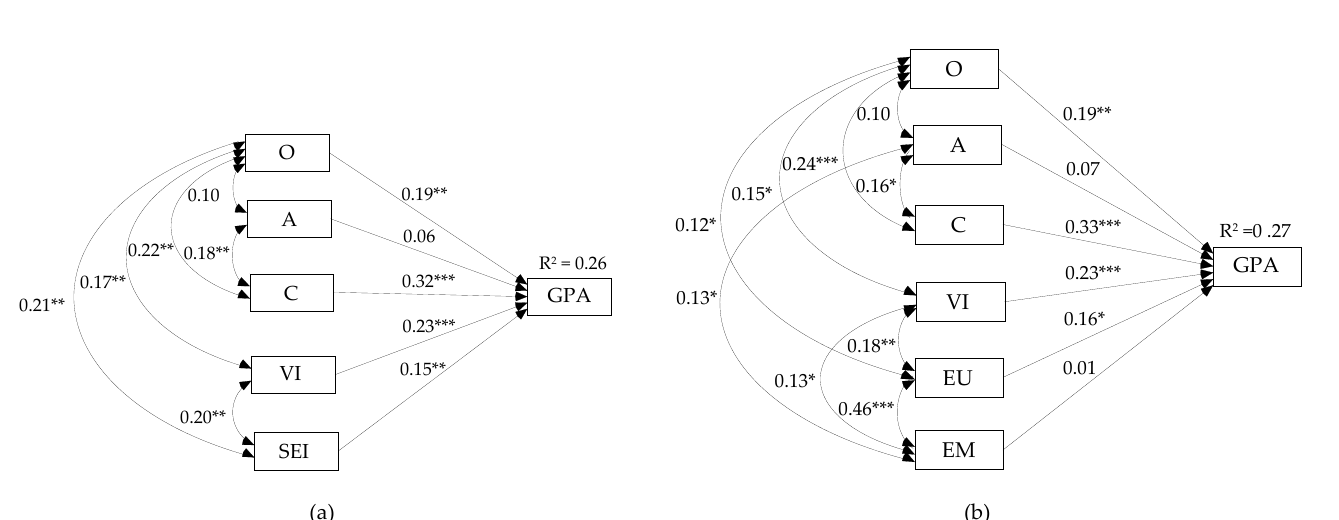
Figure 3. Standardized parameter estimates for the direct effects model with ( a ) strategic EI and ( b ) emotion understanding and management branches. GPA, grade point average; VI, verbal intelligence; A, agreeableness; C, conscientiousness; O, openness; SEI, strategic emotional intelligence; EU, emotion understanding; EM, emotion management. * p < 0.05, ** p < 0.01, *** p < 0.001.